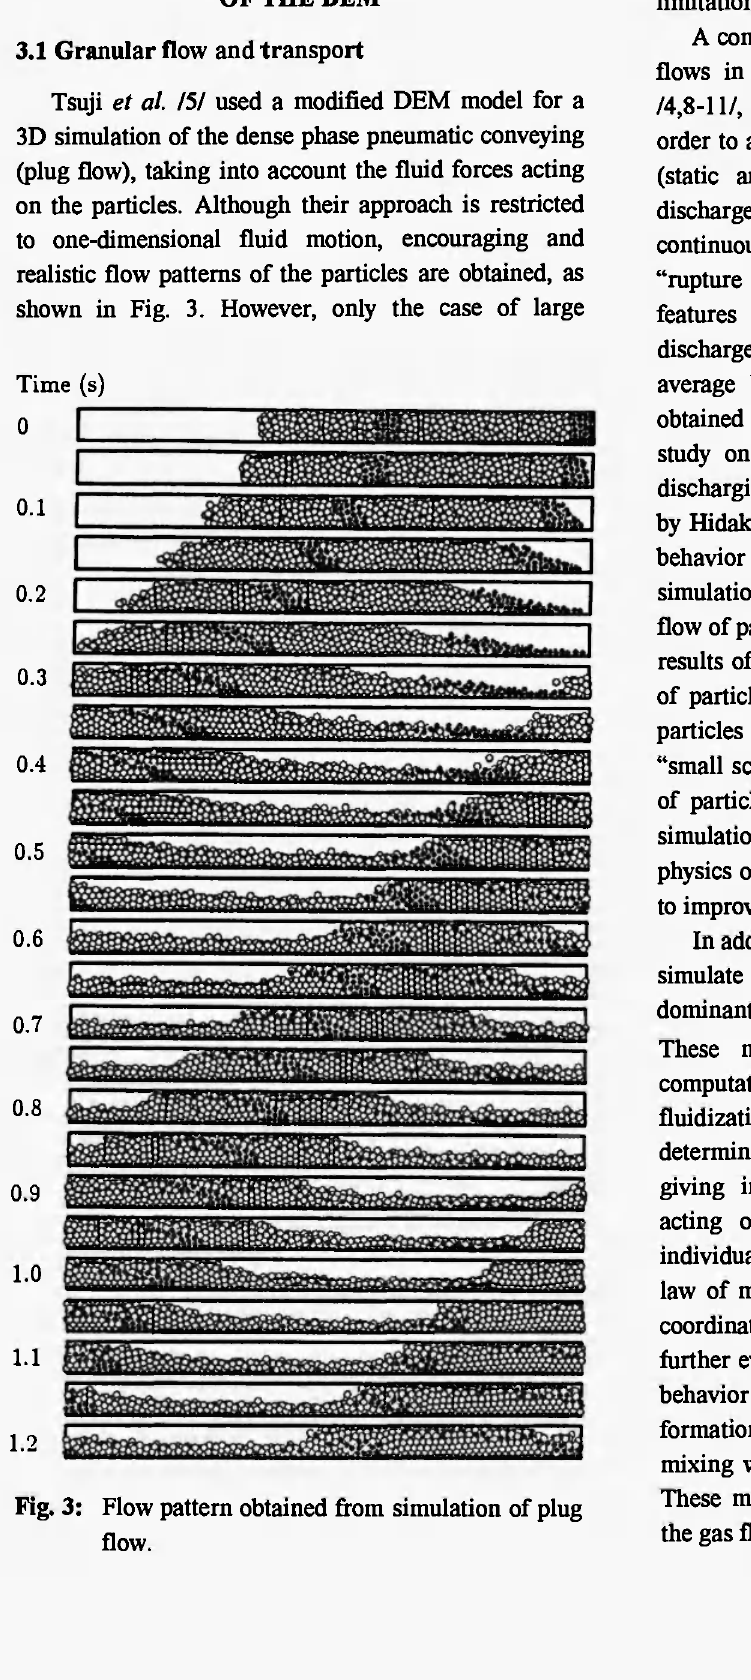
Fig. 3: Flow pattern obtained from simulation of plug